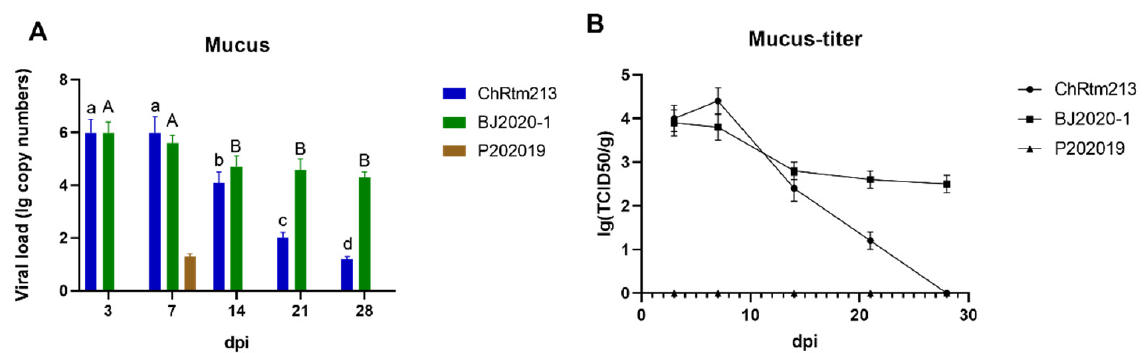
Different letters of the same class indicated the statistical significance, p < 0.05. a, b, c, d indicated